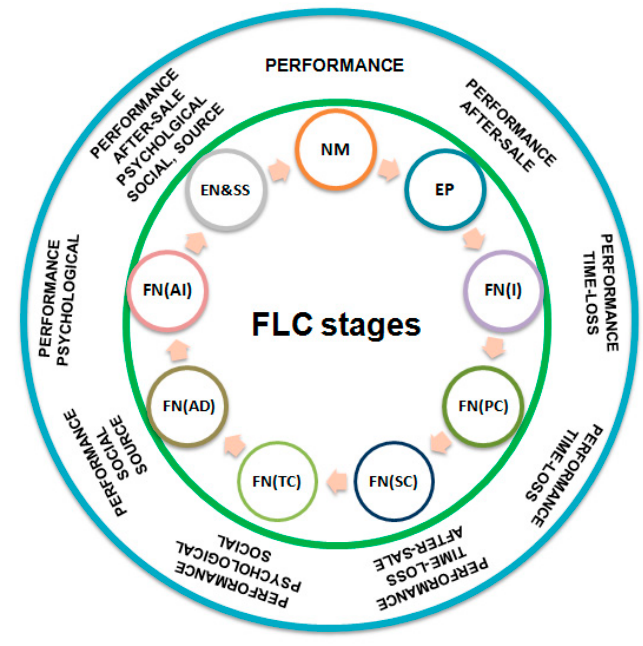
Figure 3. Risk Dimensions Influencing Women across Different FLC stages. (Based on PLS-SEM Results Shown in Table 4).